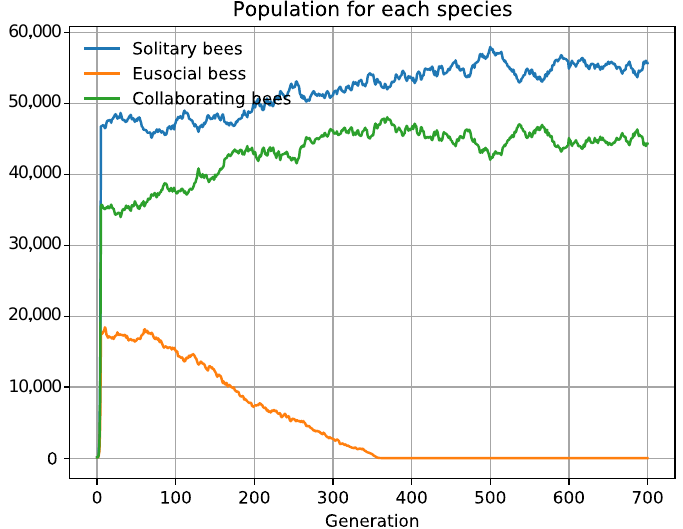
Figure 4. Uniform fragmentation and distribution do not favor social animals. Three types of bees compete, ceteris paribus . Eusocial bees are extinguished, and intra-specific collaborators have a smaller population when the habitat is fragmented (100 cells) and uniform distribution ( 100n ). The need of social animals to interact thwarts their biotic potential when the habitat does not favor interaction, as occurs with uniform distribution and fragmented habitats.